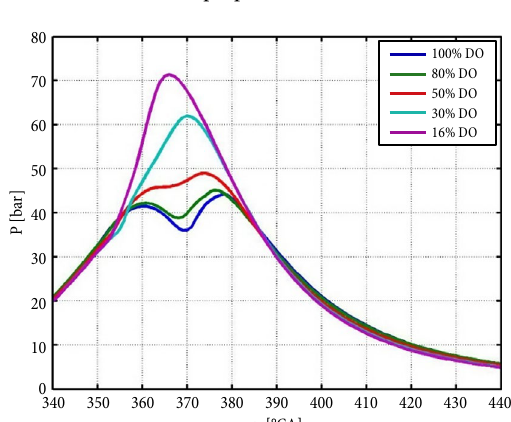
Fig. 4. Average recorded pressure versus CA for dual-fuel operation; n = 1500 rpm; T = 100 Nm (at different proportions of diesel oil)